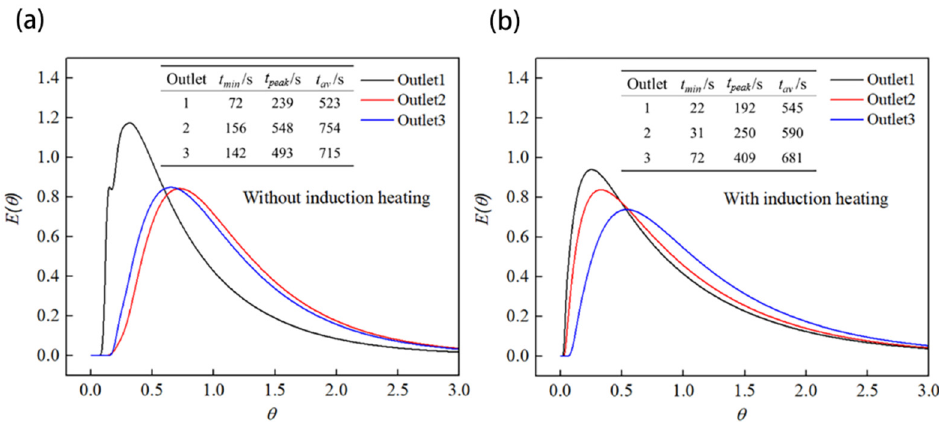
Figure 13. Comparison of RTD (residence time distribution) curves of case S0: ( a ) without induc- tion heating; ( b ) with induction heating. heating; ( b ) with induction